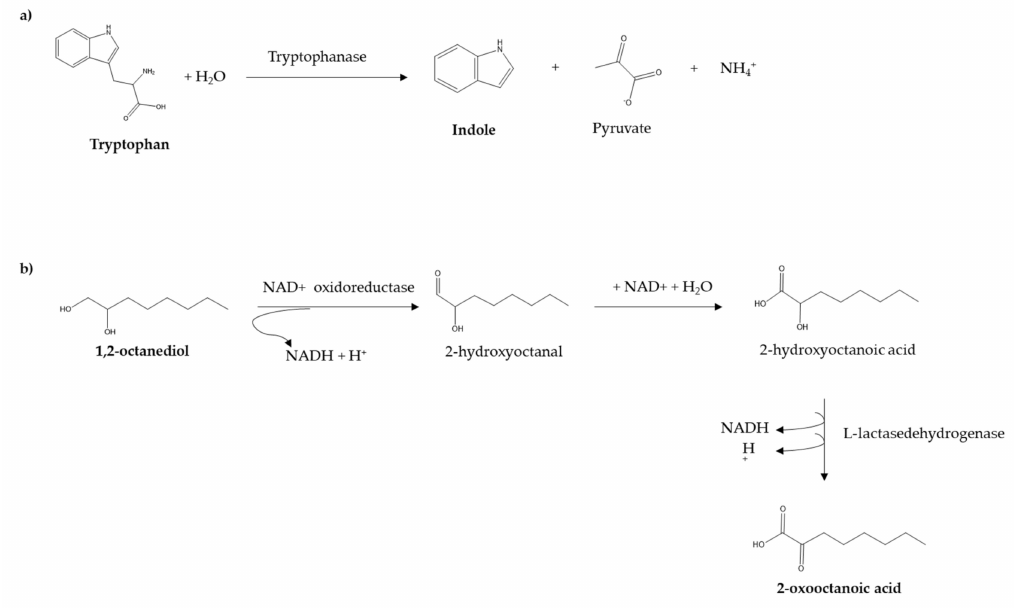
Figure 9. Proposed metabolic pathways for the formation of ( a ) indole from API ® 10 S substrate, and ( b ) 2-oxooctanoic acid from a cosmetic